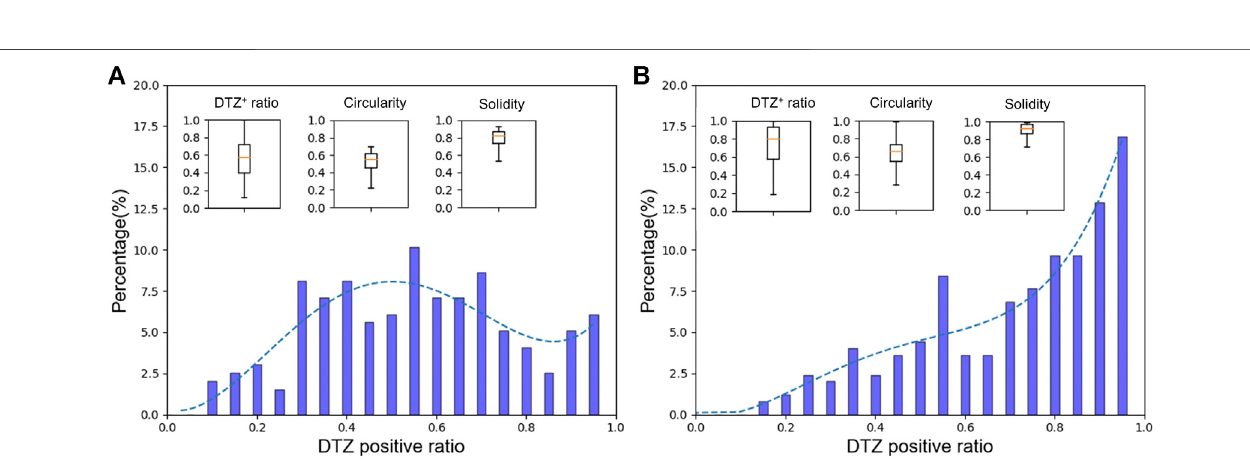
FIGURE9| Trappedisletpercentageassessment. (A) Assessmentformiddlelayerislets.TheisletsamplehasanaverageDTZ + ratioof0.576 ± 0.223,anaverage circularity of0.534 ± 0.102,and an average solidityof0.793 ± 0.102. N (cid:1) 198. (B) Assessmentfortop layer islets. Theislet sample hasan averageDTZ + ratioof0.735 ± 0.213, an average circularity of 0.635 ± 0.139, and an average solidity of 0.853 ± 0.107. N (cid:1)